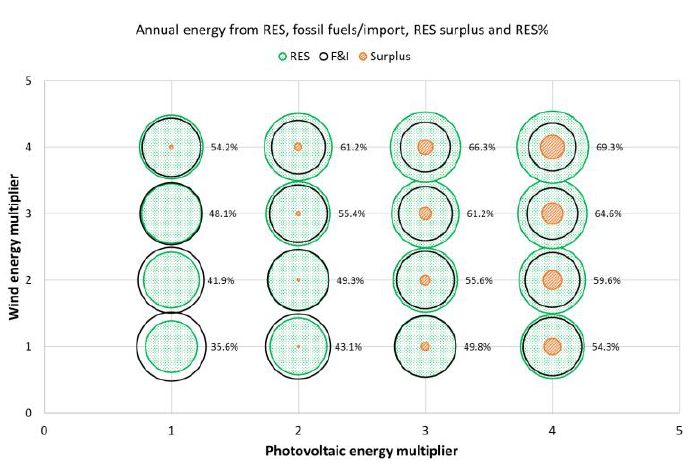
Figure 18. Annual energy from RES, fossil fuel/imports, RES surplus and RES% for different values of wind and photovoltaic